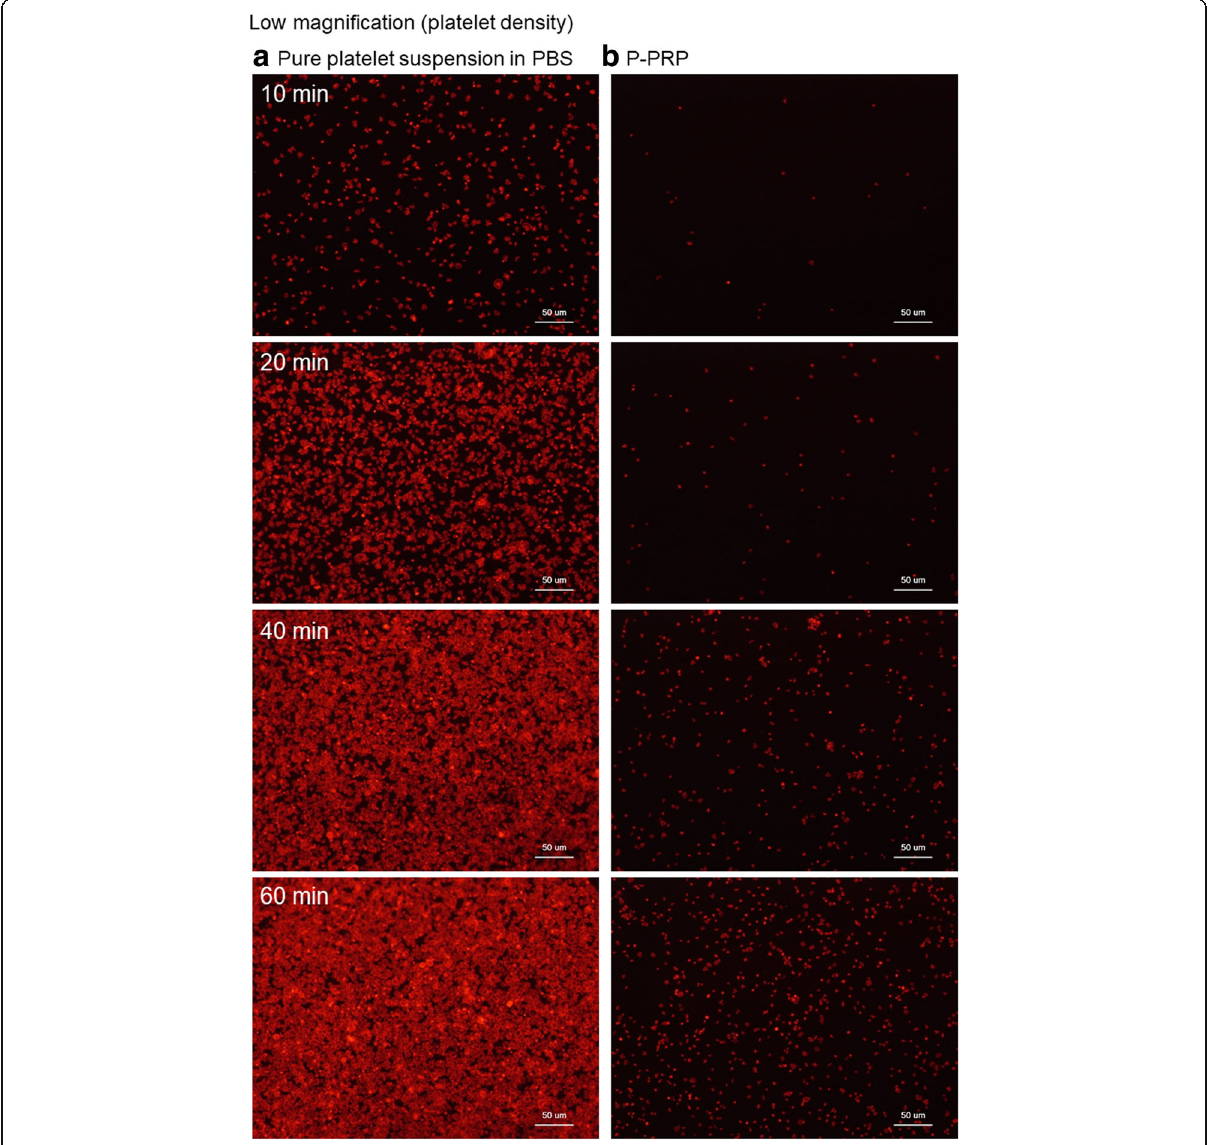
Fig. 2 Time-course changes in platelet adhesion to the surface of cp -Ti plates. a Platelets suspended in PBS and b P-PRP. Actin fibers (F-actin) formed in platelets, indicating densities of platelets, are represented by a red dye. cp - Ti commercially pure titanium, PBS phosphate-buffered saline, P-PRP pure platelet-rich